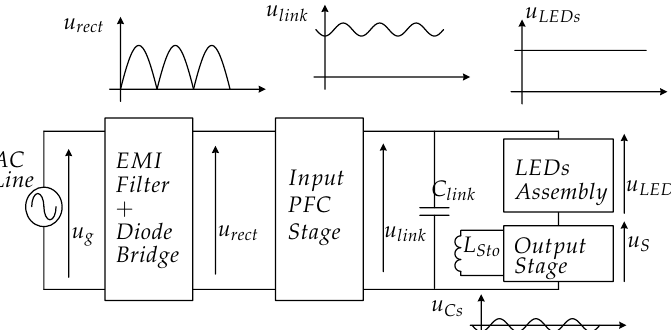
Figure 2. Proposed scheme. The second stage processes the small amount of AC power, thus keeping high efficiency and small LEDs current ripple.